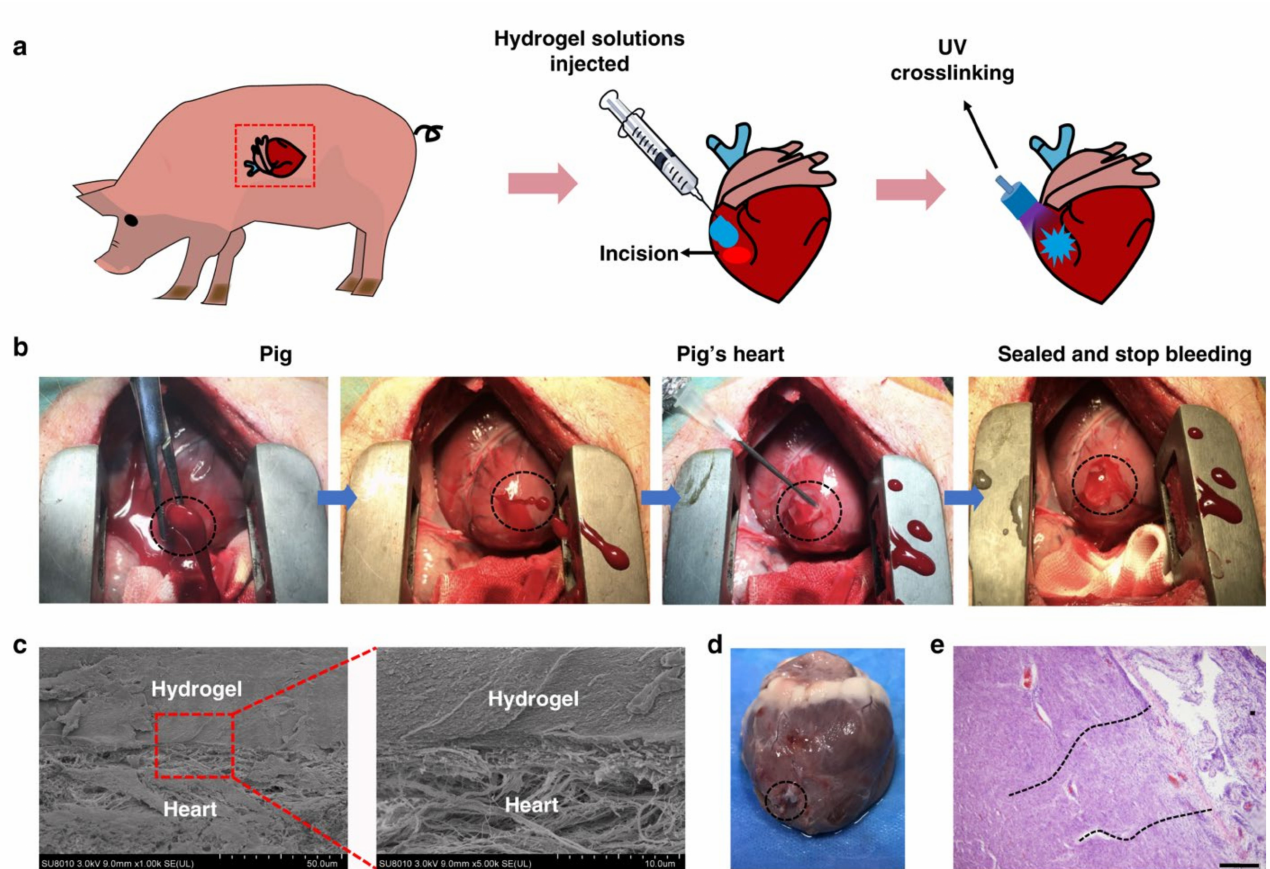
Figure 2. Selective results for hemostatic properties of GelMA:HA-NB matrix hydrogel prepared using rapid polymerization using UV light radiation. ( a ) Schematic showing a surgical procedure in a pig cardiac puncture injury model. ( b ) Images showing the real surgical procedure, application of hydrogel, and hemostatic efficacy of hydrogel, where hydrogel stops bleeding completely within 30 s in a 6 mm pig cardiac injury. ( c ) SEM images showing the interface between hydrogel and pig’s heart obtained from immediate postoperative autopsy on the heart of a pig. ( d , e ) Heart autopsy and tissue staining images of the interface between hydrogel and hearts of a pig after two weeks of post-operative recovery. Adapted with permission from [32]. Copyright © 2019, Springer